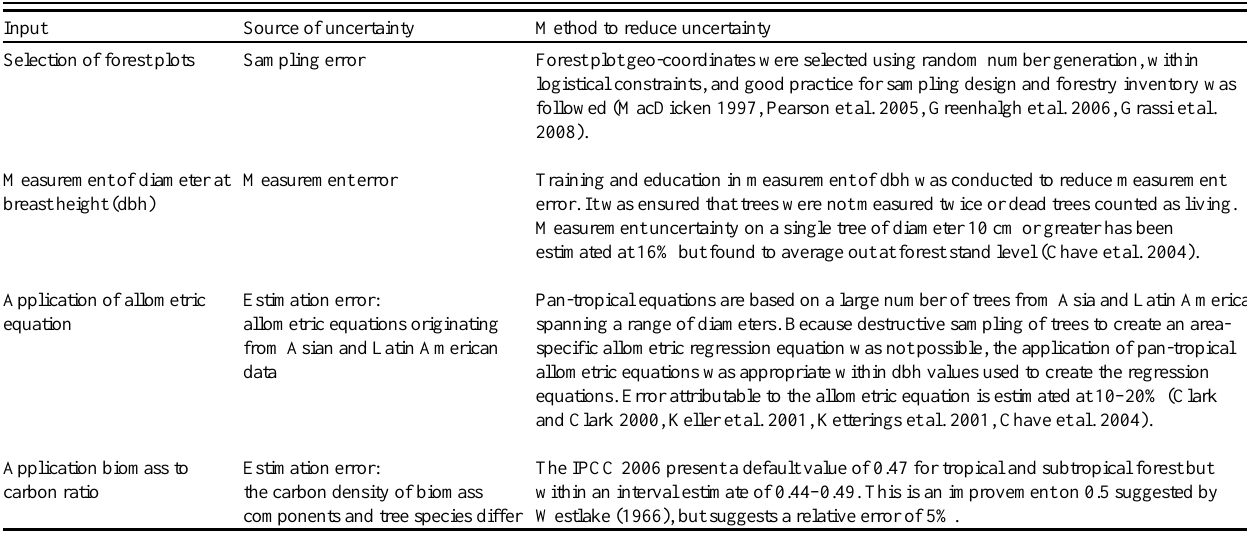
Table 1 . Inputs and sources of uncertainty in estimates of forest carbon stock, as well as methods applied to reduce these